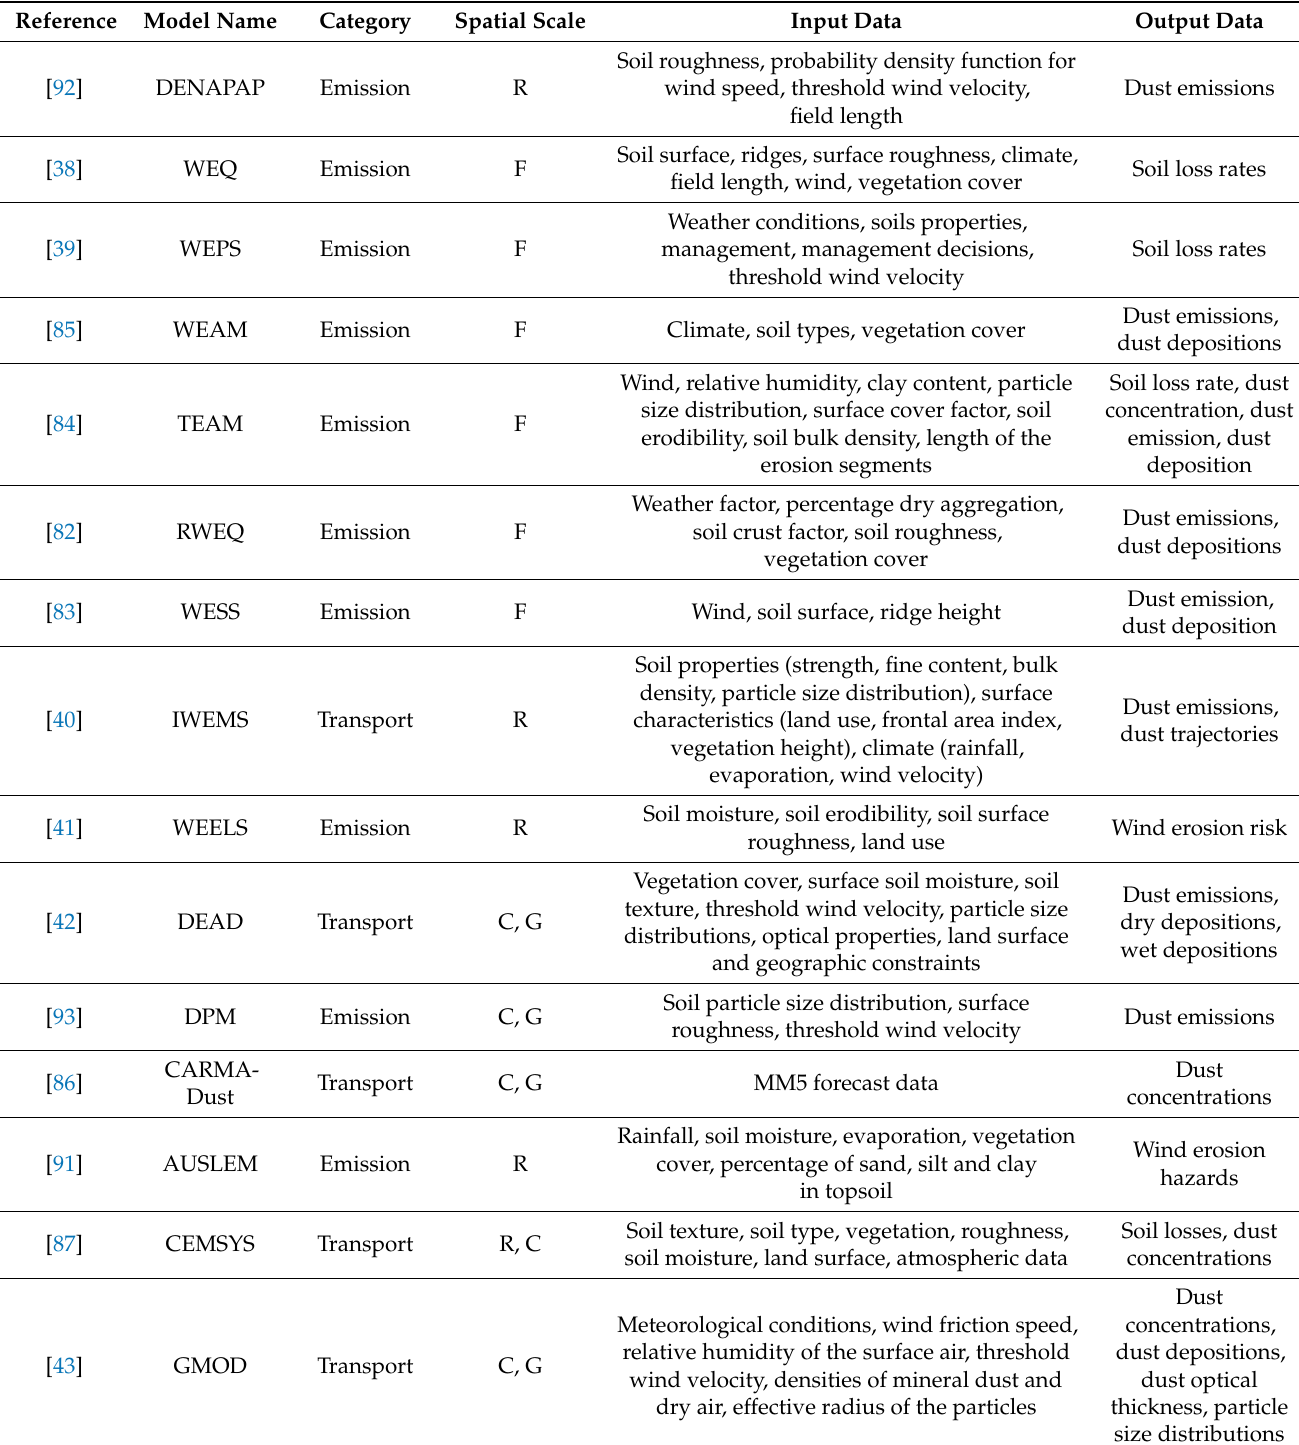
Table 1. Summary of reviewed dust models, including spatial scale, inputs, and